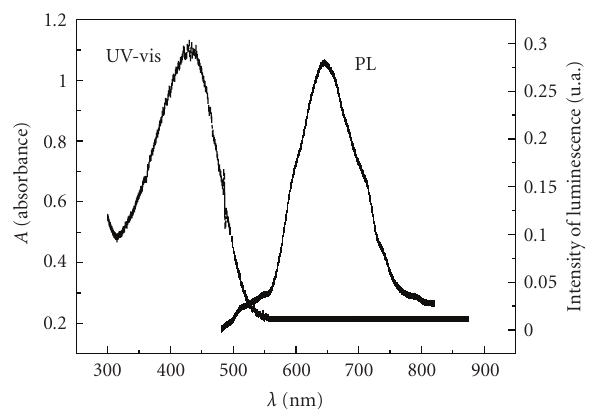
Figure 6: Photoluminescent and UV-vis spectra of copolymer [5] in CHCl 3